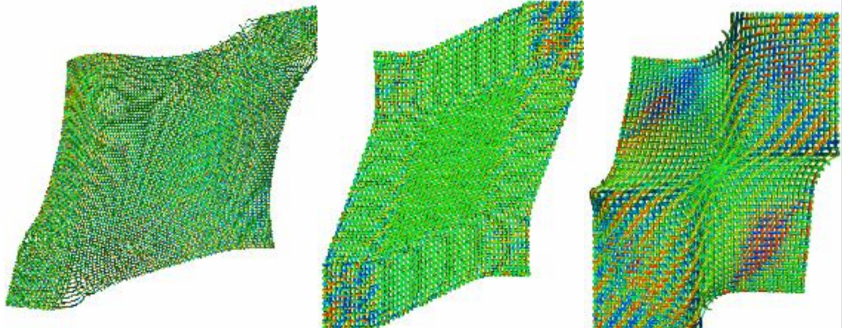
Figure 3. Qualitative simulation of a shear test with increasing measure of the clamped boundary (studied in [6]).